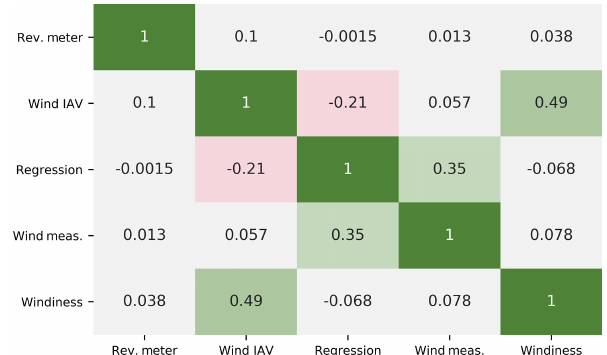
Figure 6. Correlation coefficient heat map between operational AEP uncertainty components, as calculated from each pair of AEP uncertainty components across the 472 wind plants considered in the analysis. Note that “Rev.” denotes